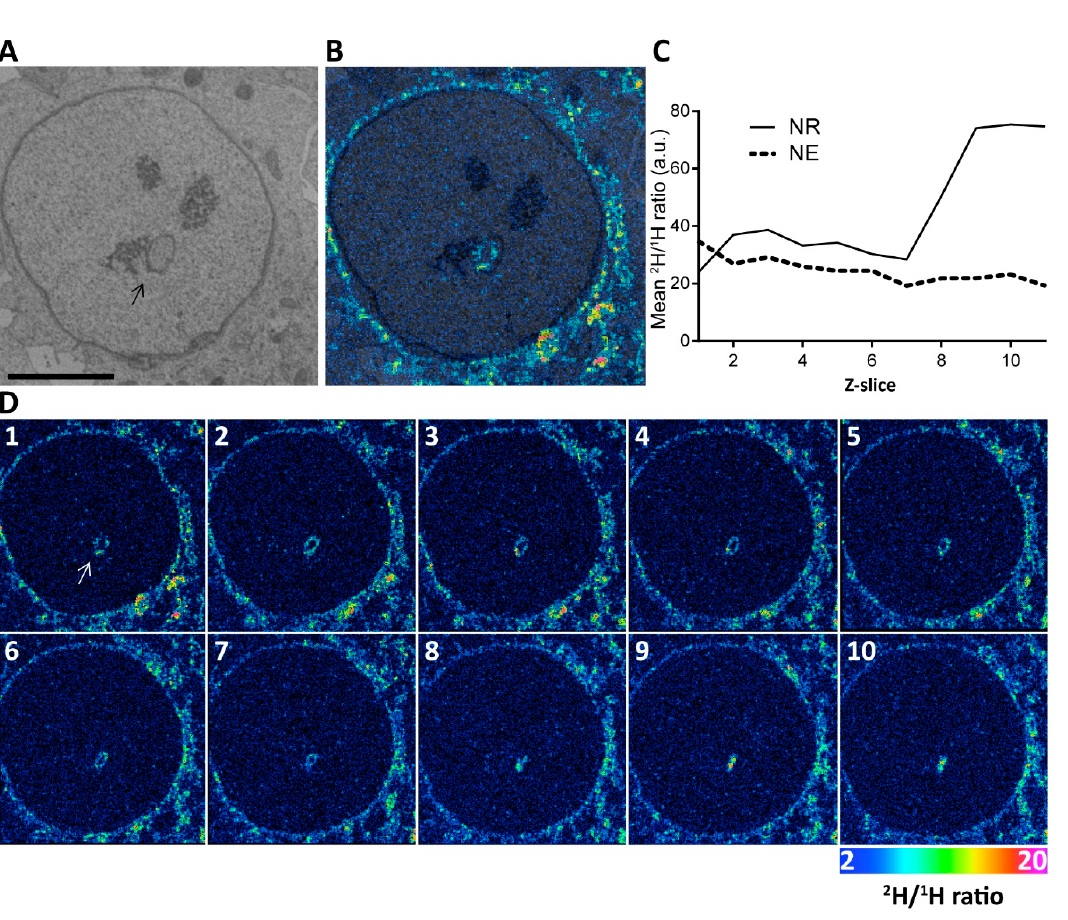
Figure 5. Nascent phospholipids are incorporated in the forming NR during estradiol stimulation. ( A ) Representative backscattered electron micrograph of an Ishikawa nucleus pulse labelled with deuterated choline. Arrow points to an NR channel. Scale bar 5 µm. ( B ) Overlay of the electron micrograph and NanoSIMS image showing deuterium enrichment at the invagination. ( C ) Quantification of the mean 2 H/ 1 H ratio in the NR versus the NE rim for the ion-beam eroded z-series through this cell. The average 2 H/ 1 H ratio for two regions of interest (total NE and NR) are shown for each z plane. This shows increasing nascent deuterated choline signal in the tip of the NR invagination where no lumen is visible. See also Supplementary Movie 1. ( D ) Panel of individual sections of 3D reconstruction. Color scale of NanoSIMS images 2–20 equals 0.02–0.2% of 2 H/ 1 H ratio.